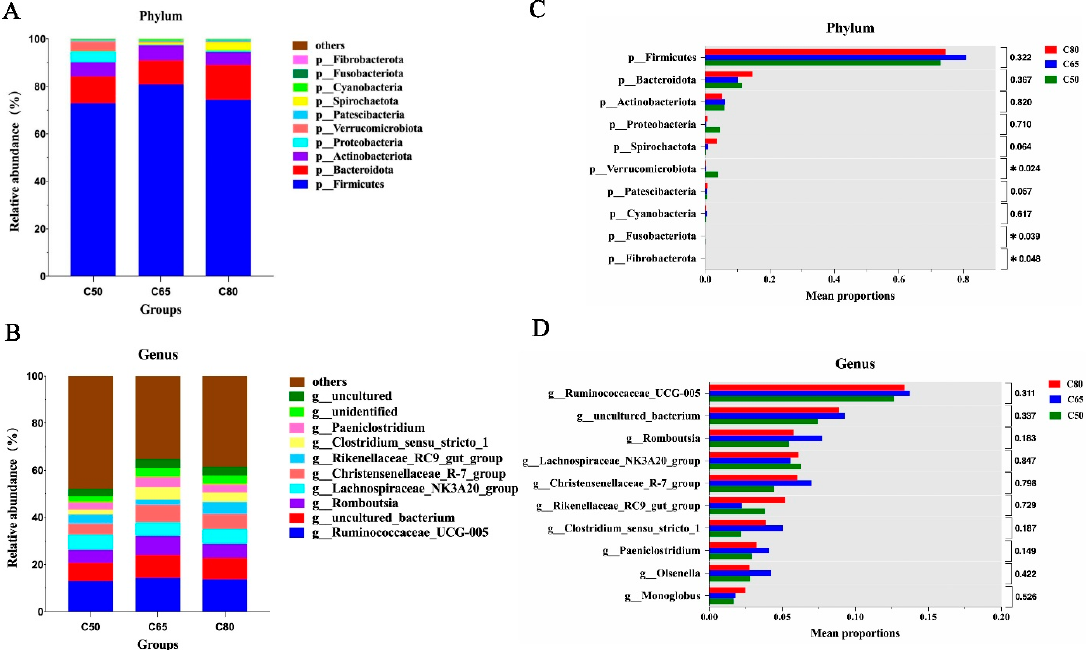
Figure 3. The bacterial composition of rumen samples from yaks with different dietary concentrate- to-forage ratios. Bacterial composition at the phylum ( A ) and genus ( B ) levels; Significantly different bacterial phylum ( C ) and genus ( D ) between groups, where different letters indicate significant differences between groups.